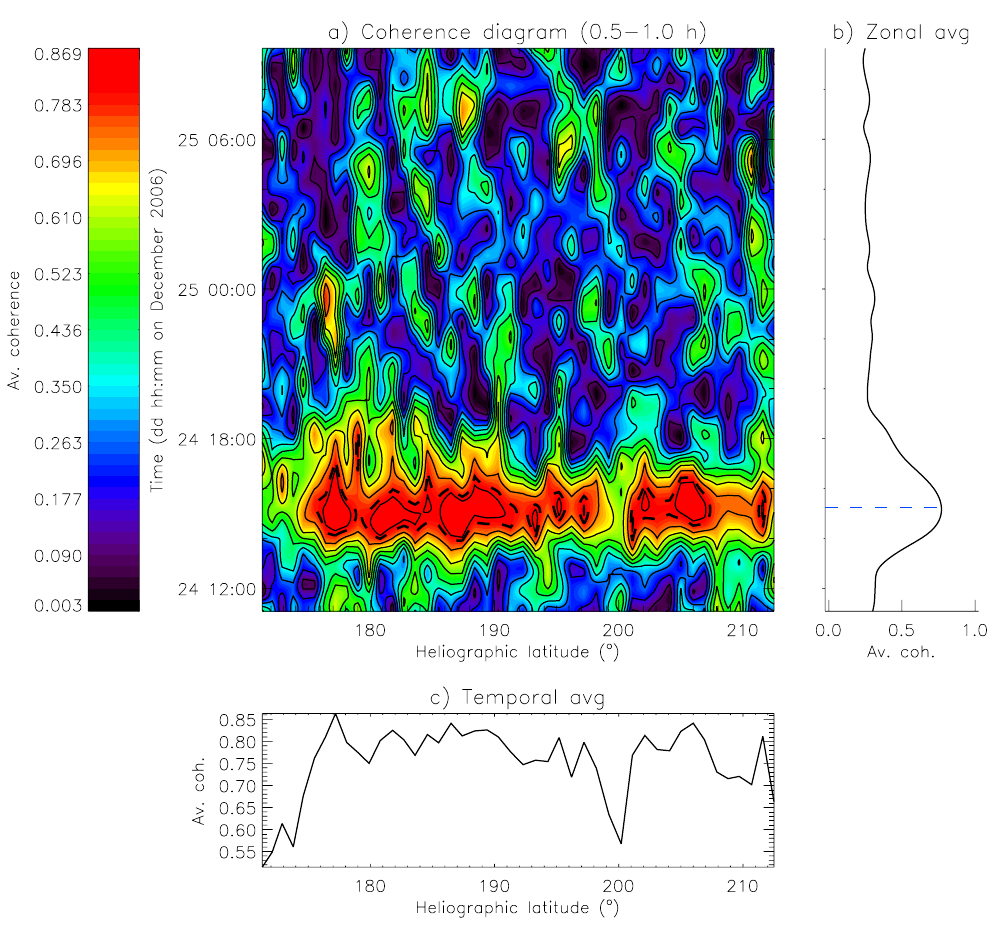
Figure 5. ( a ) Time-latitude diagram of the degree of coherence of the non-stationary oscillations with periods of 0.5–1 h along the UVCS slit; the left axis is time; the bottom axis is heliographic latitude; the thick dashed contour is the 95% confidence level. ( b ) Average of ( a ) over all latitudes; the blue dashed line indicates the time (15:14 UT) of the first peak in the H I Ly α intensity. ( c ) Average of ( a ) over the time interval from t 1 = 14:42 UT to t 2 = 15:30 UT on 24 December